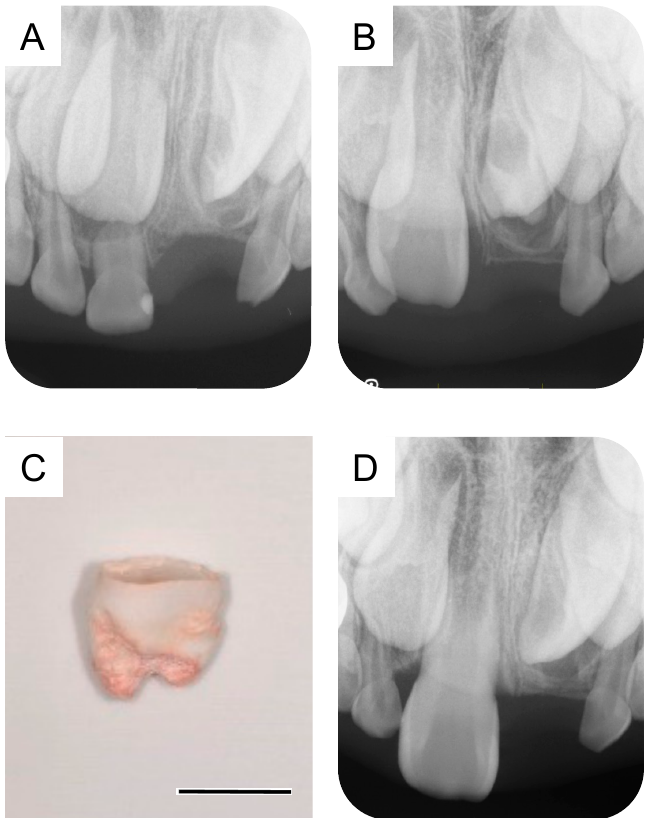
Figure 2. Extraction of the second supernumerary tooth. ( A ) Periapical radiograph after the extraction of the first supernumerary tooth at the age of 6 years and 3 months. ( B ) Periapical radiograph of the second supernumerary tooth detected at the age of 7 years and 5 months. ( C ) Extracted second supernumerary tooth at the age of 7 years and 7 months. Scale bar: 5 mm. ( D ) Periapical radiograph after the extraction of the second supernumerary tooth at the age of 7 years and 9 months.